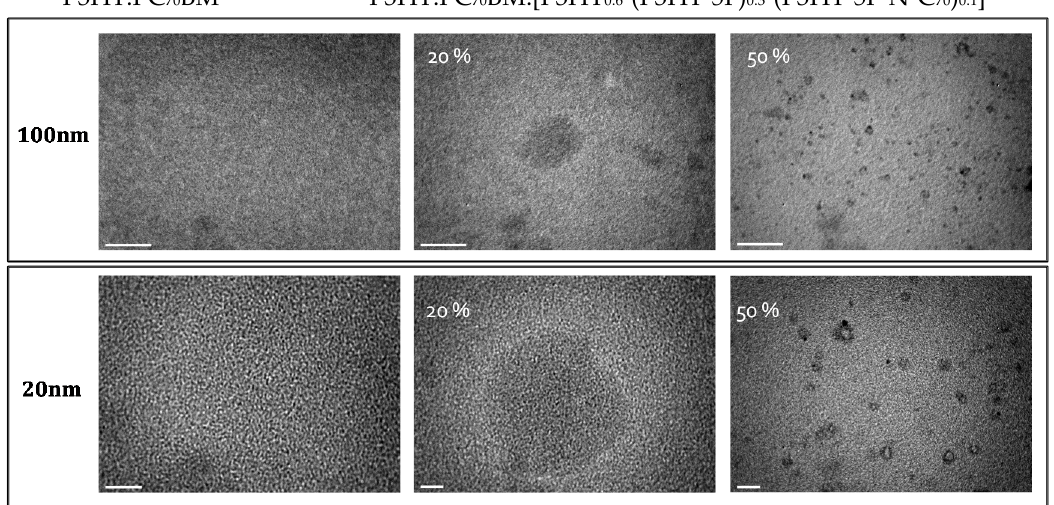
Figure 11. TEM images of a P3HT:PC 70 BM 1:1 w / w blend and of P3HT:PC 70 BM: [P3HT 0.6 -(P3HT-5F) 0.3 -(P3HT-5F-N-C 70 ) 0.1 ] blends with a 20 wt % and a 50 wt % of the [P3HT 0.6 -(P3HT-5F) 0.3 -(P3HT-5F-N-C 70 ) 0.1 ] hybrid, respectively. For the top images, the scale bars correspond to 100 nm while, for the bottom images, they correspond to 20 nm.